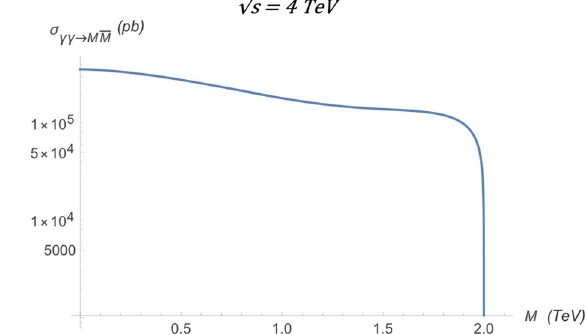
Fig. 3 Differential cross section distributions for the production of spin-0 monopoles of mass M = 1 . 5 TeV via PF at E γ = 6 M , as a function of the scattering angle θ (left) and the pseudorapidity η (right)